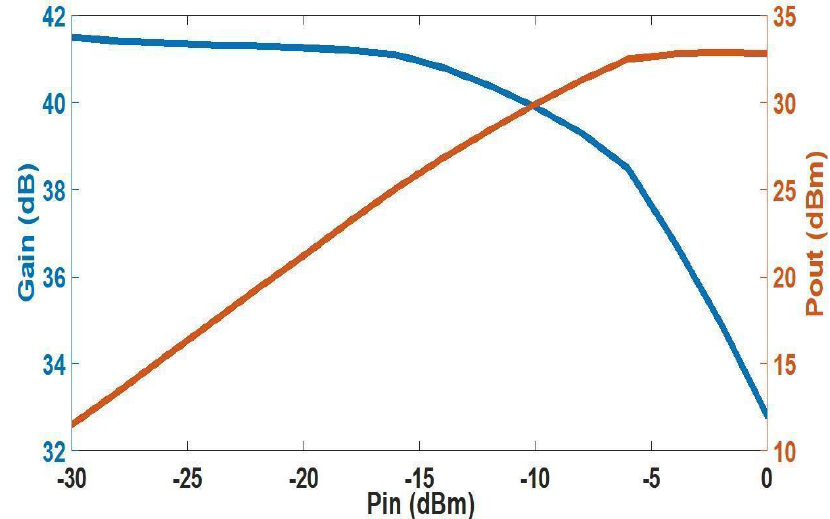
Figure 12. Power and gain characteristics of the conditioning block at 2.25 GHz.